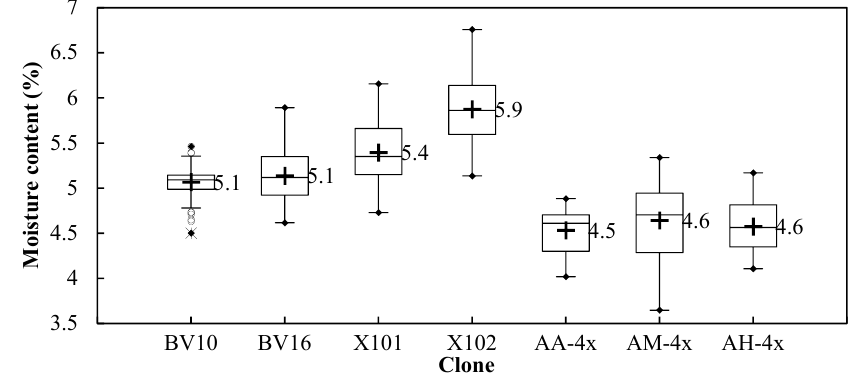
Figure 2. Variation of moisture content (%).